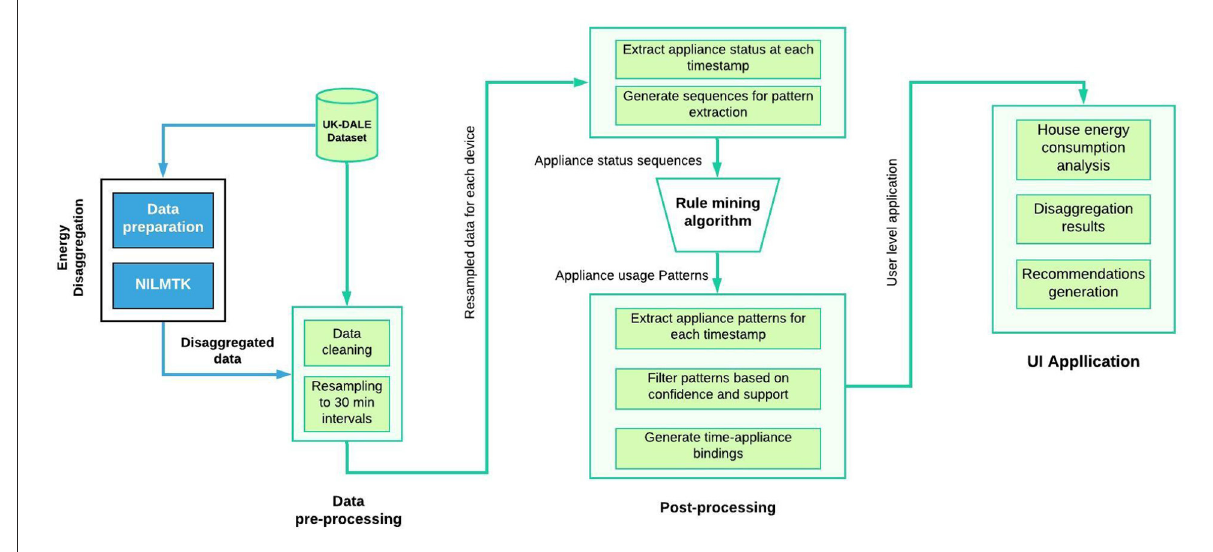
FIGURE1 The main processing flow of the proposed